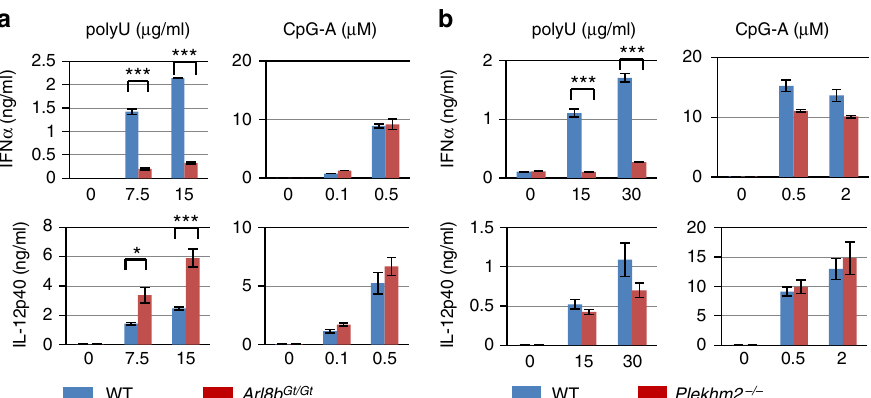
Fig. 4 Arl8b and Plekhm2 are essential for IFN- α expression. a , b WT (blue), Arl8b Gt/Gt (red), and Plekhm2 − / − (red) BM-pDCs were stimulated or not with either polyU or CpG-A at the indicated concentrations. Production of IFN- α and IL-12p40 was measured by ELISA. Data are presented as mean ± s.d. of triplicate wells. Similar experiments were repeated three or four times. *** P < 0.001, * P < 0.05 (unpaired two-tailed t